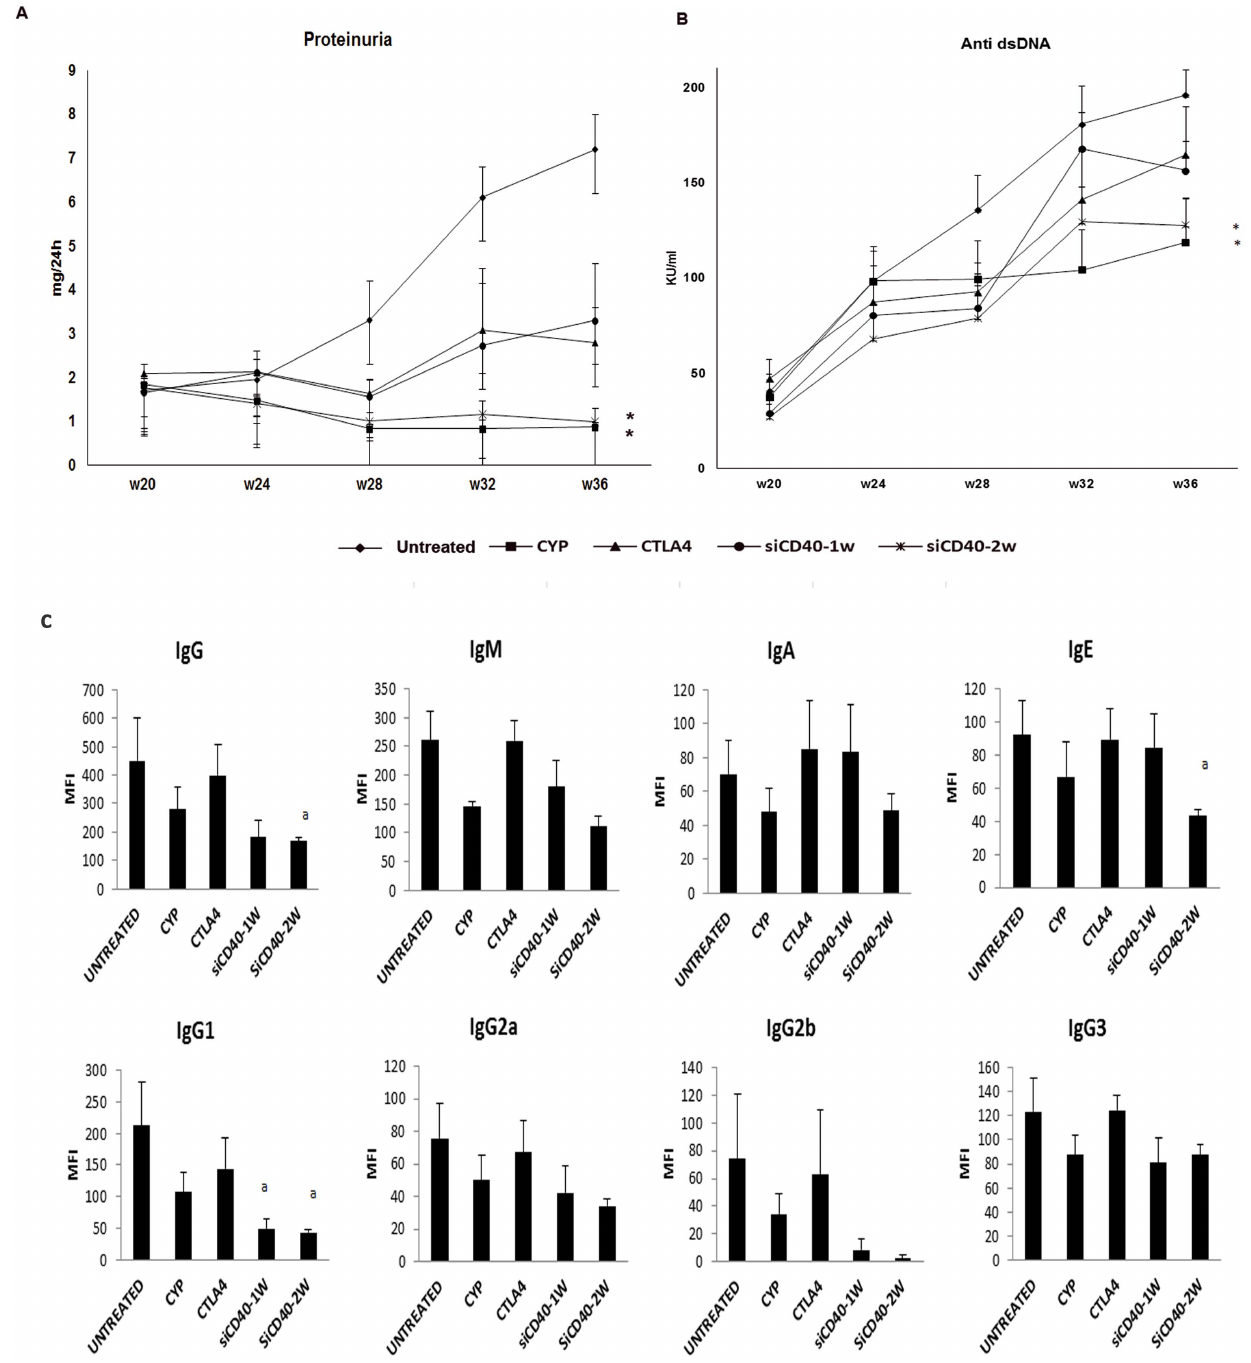
Figure 3. Proteinuria, anti dsDNA antibodies and Immunoglobulin isotype. A) 24 h-Proteinuria increased progressively in non treated mice to levels of heavy proteinuria. Treatment with CYP or siRNA anti CD40 twice per week induced a progressive reduction of proteinuria to levels almost physiological. B) Anti dsDNA antibodies increased progressively in non treated mice; siRNA anti CD40 twice per week reduced this production more effectively than CTLA4 or siCD40-1w group. C) Circulating immunoglobulin subclasses characterization. CD40 blockade with Chol-siRNA reduced total IgG and all IgG fractions. Data are expressed as mean 6 SEM of four separate experiments, p , 0.05 a vs untreated.